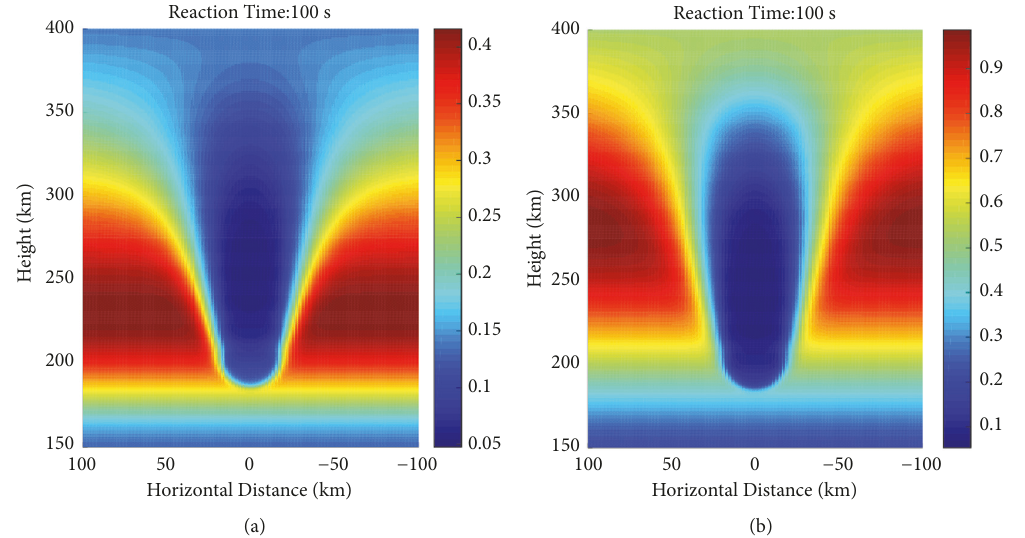
Figure 8: (a) Electron density profiles of H 2 O released from the ionosphere in simulated plumes in Yinchuan; (b) electron density profiles of H 2 O released from the ionosphere in simulated plumes in